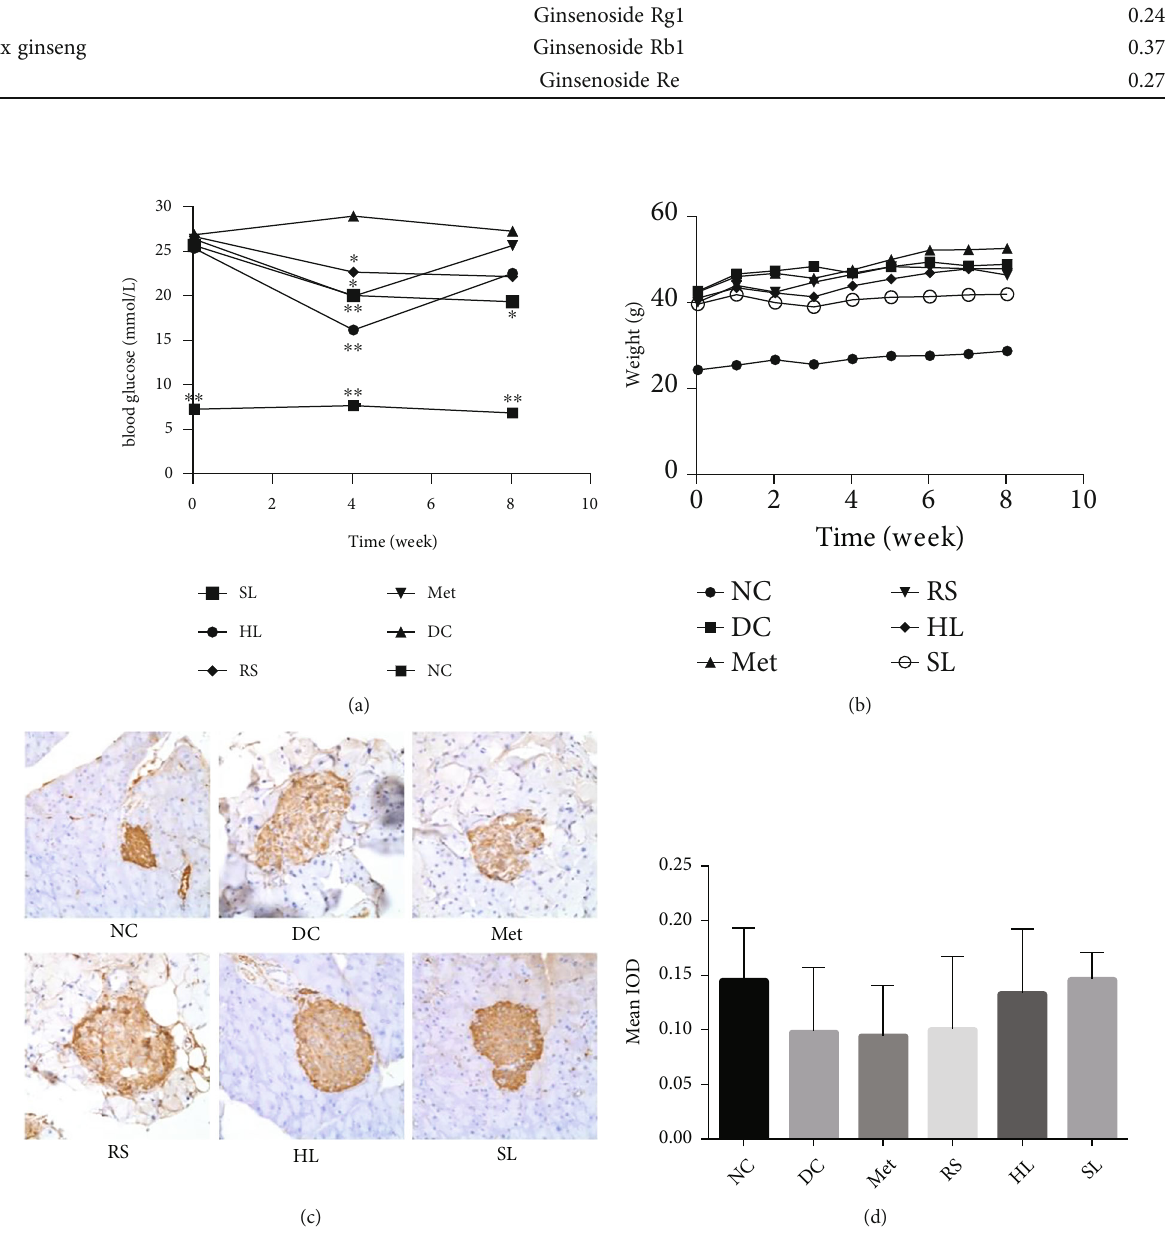
Figure 1: E ff ects on (a) FBG, (b) body weight, and (c, d) HOMA-IR. Immunohistochemistry of insulin in islet tissue. ∗ P < 0 : 05 vs. DC group; ∗∗ P < 0 : 01 ; ∗∗∗ P < 0 : 001 .